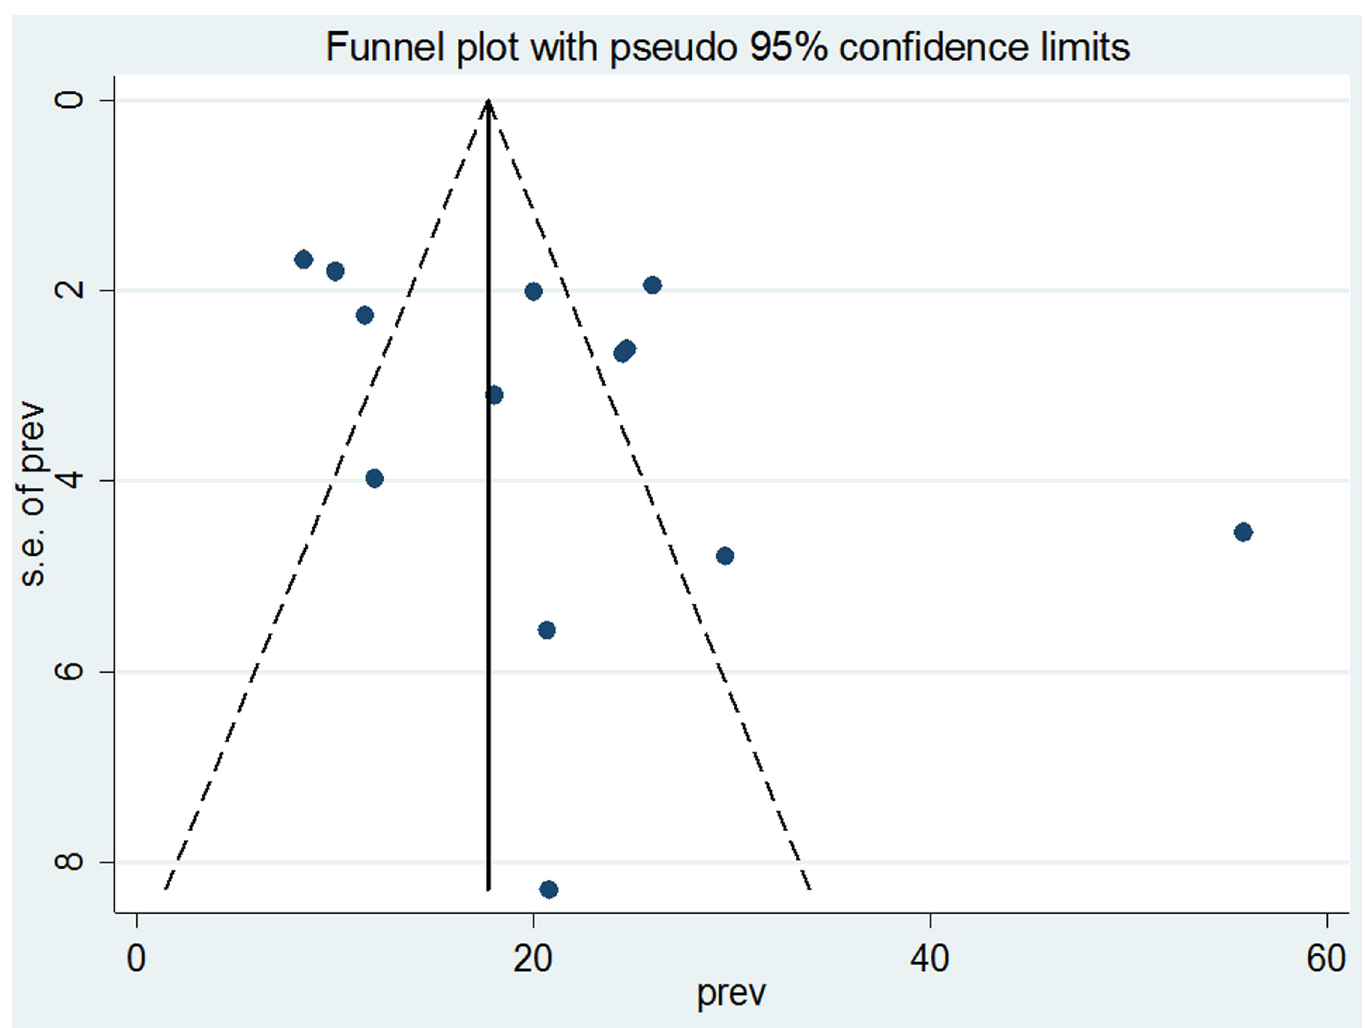
Fig 3. Funnel plot to assess publication bias for non-adherence to anti TB treatment in